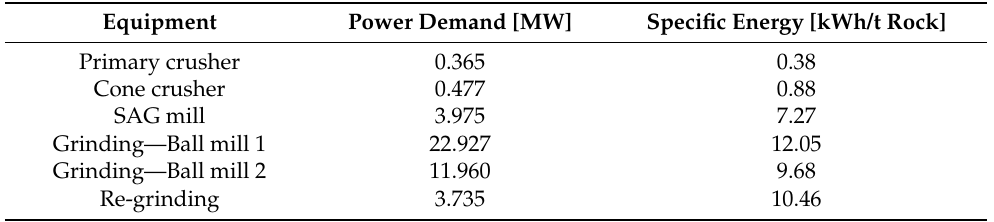
Figure 2. Comminution process. Table 3. Detail of the units of the comminution process for scenario